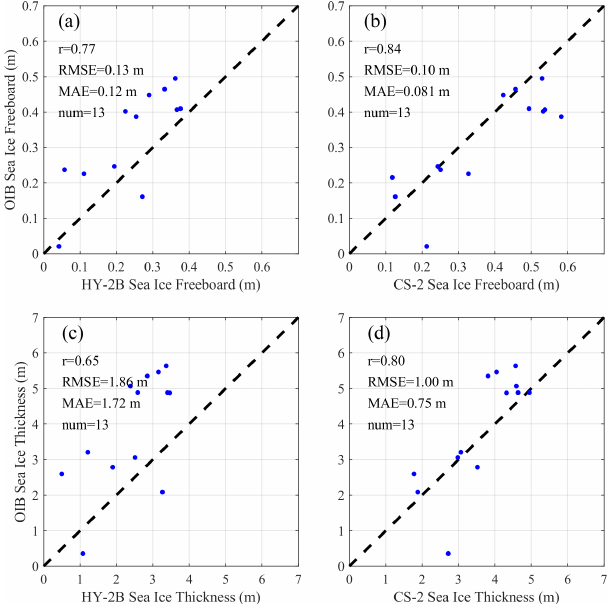
Figure 8. Comparative scatter plots between two satellite products and OIB collected in April 2019: (a) HY-2B sea ice freeboard vs. OIB sea ice freeboard, (b) AWI CS-2 sea ice freeboard vs. OIB sea ice freeboard, (c) HY-2B sea ice thickness vs. OIB sea ice thickness and (d) AWI CS-2 sea ice thickness vs. OIB sea ice